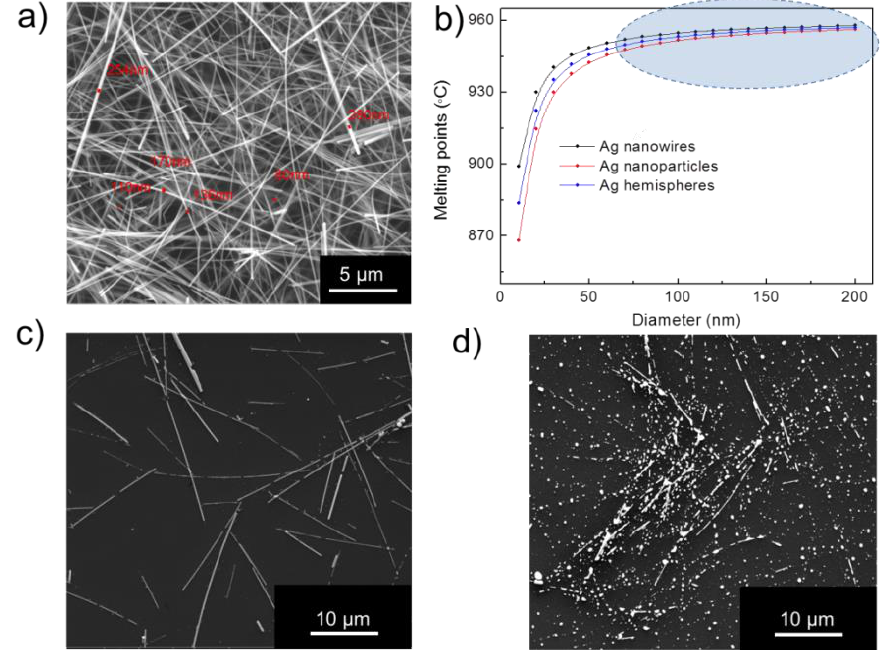
Figure 2. ( a ), Morphologies of Ag nanowires with various diameters; ( b ), melting points of Ag nanowires, nanoparticles and hemispheres with diameters ranging from 10 nm to 200 nm; ( c ),( d ) morphologies of Ag nanowires treated by vacuum heating under 200 °C and 450 °C for 6 h.